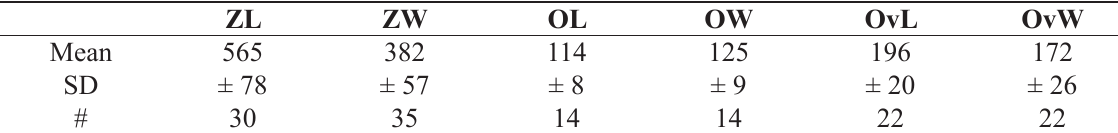
Table 8. Measurements of Atlantisina lionensis gen. et sp. nov.